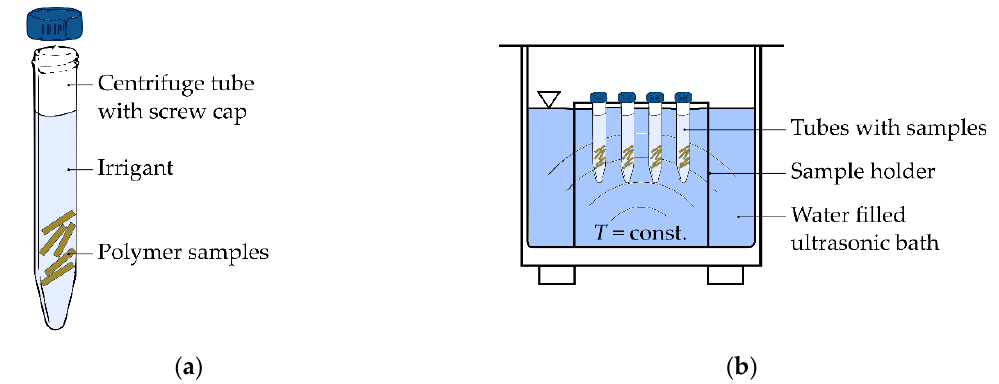
Figure 2. Storage of polymer samples in irrigant with a mass concentration 𝛾 𝑖 and constant temperature 𝑇 : ( a ) set of samples for one chemical exposure condition and time; ( b ) arrangement of tubes for ultrasonic excitation.